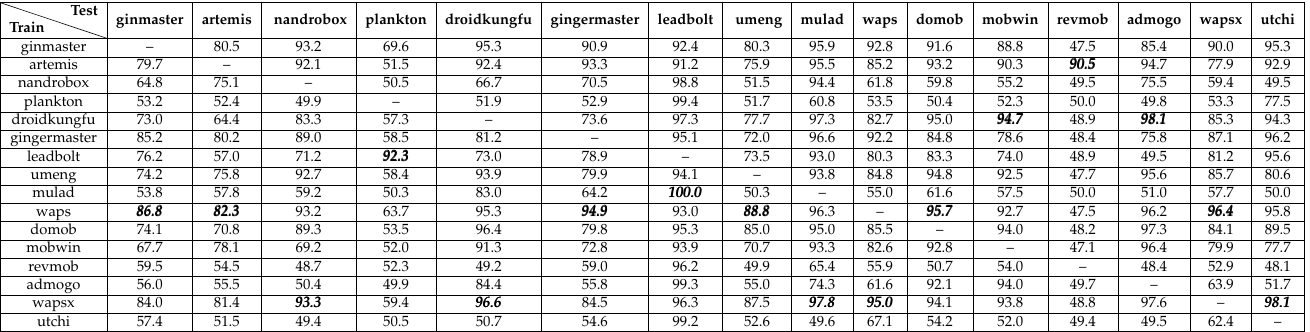
Table 4. Malware detection performance with different malware families in the training set using drebin. The number in bolds show the best results.